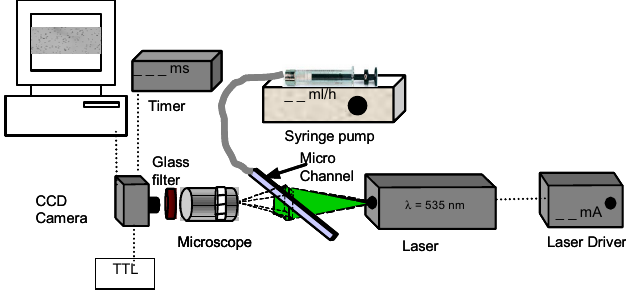
Fig. 2. (Color online) Block-schema of the experimental